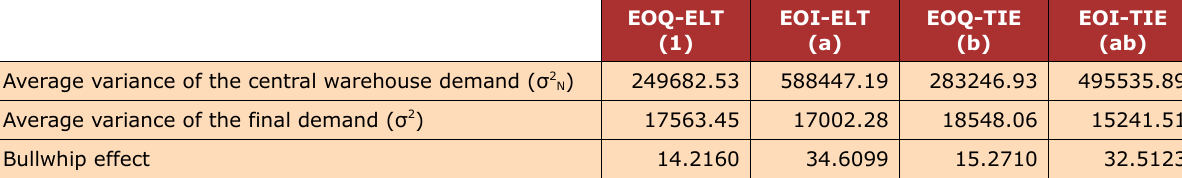
Table 3. Results of the Bullwhip effect analysis